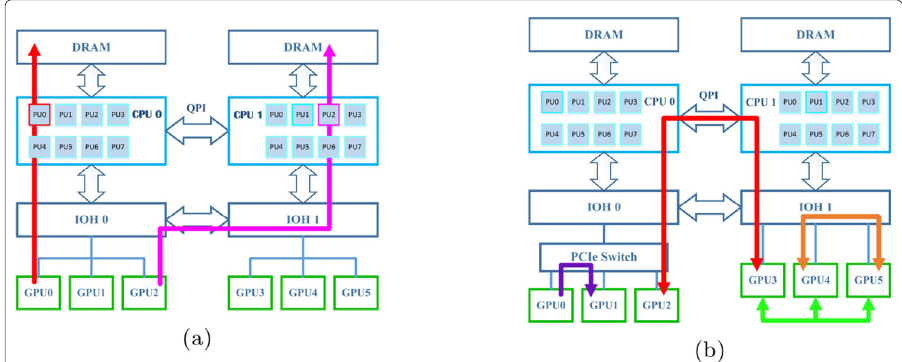
Fig. 7 CPU-GPU and GPU-GPU memory access models. In ( a ), red path is the optimal one, while pink path is inferior because CPU to GPU memory access across NUMA nodes is worse than local access. In ( b ), if GPUs support peer-to-peer (P2P) communication technology, green path indicates that two GPUs communicate by Nvlink, which is the fast path. Purple path indicates that two GPUs communicate by PCIe switch (PLX), which is the most efficient communication way without Nvlink. Yellow path means that two GPUs communicate by host (CPU). Red path is the worst one because P2P is not supported across NUMA nodes, and memory access between two GPUs in this way must be transferred by both